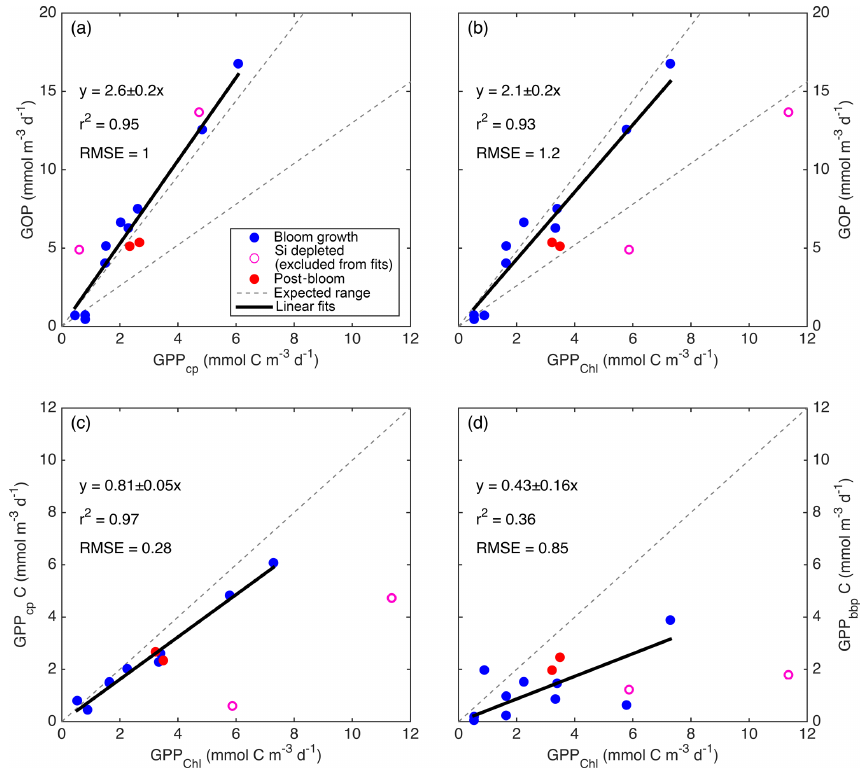
Figure 9. Relationships between primary productivity estimates: GOP vs. GPP cp (a) , GOP vs. GPP Chl a (b) , GPP cp vs. GPP Chl a (c) , and GPP bbp vs. GPP Chl a (d) . Type-I linear regressions are forced through the origin and include all data except the SiO 4 -depleted period (pink circles). The expected range of GOP / GPP ( a, b ; dashed lines) assumes a photosynthetic quotient between 1–1.45 and 22–40% of fixed carbon released as DOC (see